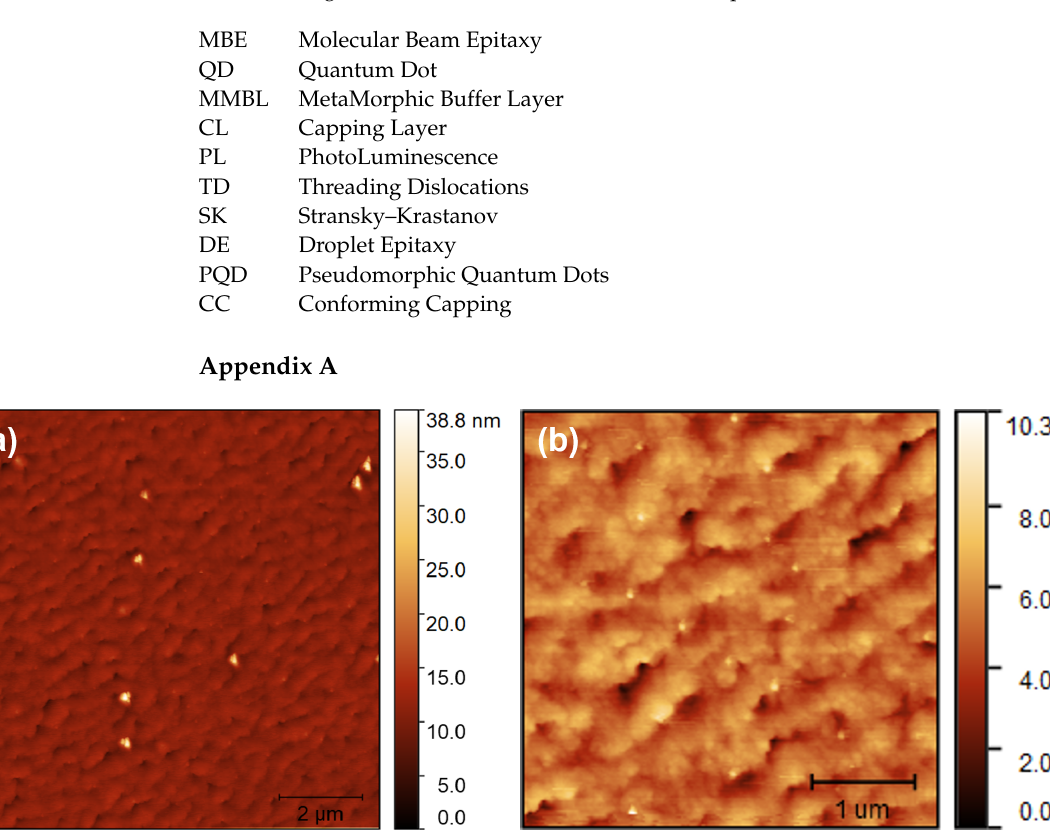
Figure A1. ( a ) 10 × 10 µ m 2 AFM topography image of Sample S6 without any capping layer; ( b ) 4 × 4 µ m 2 AFM topography image of sample